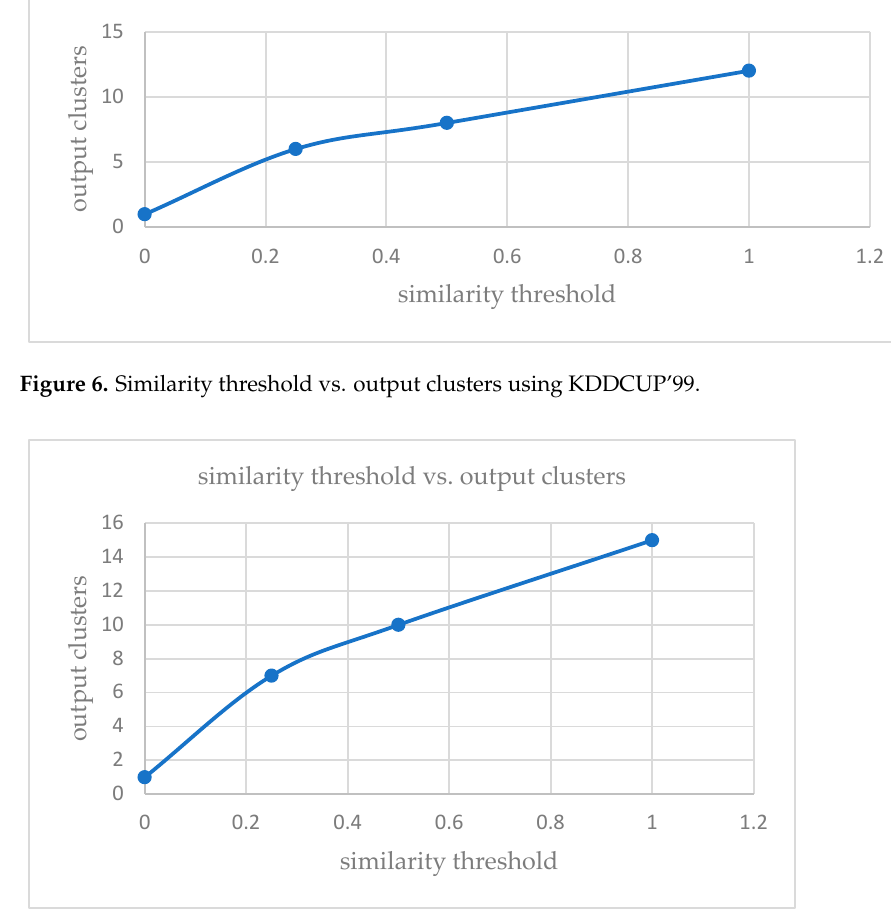
Figure 7. Similarity threshold vs. output clusters using Kitsune.